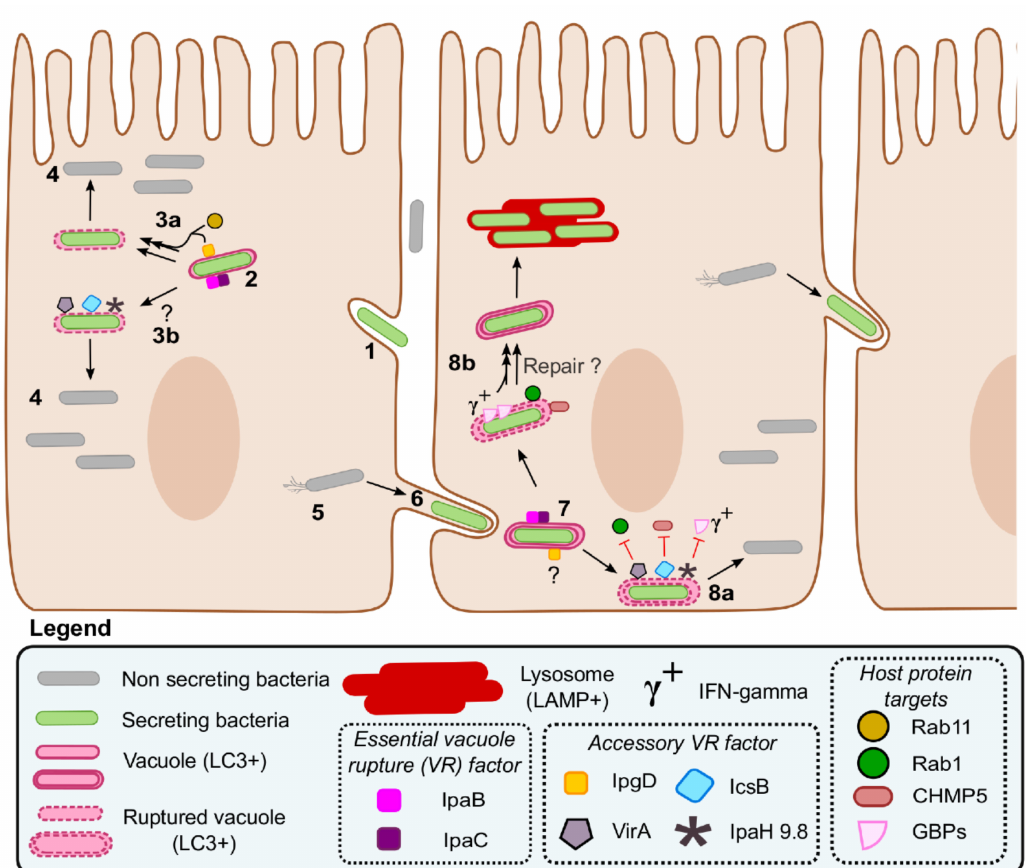
Figure 5. Shigella intracellular lifestyle and role of its virulence factors during vacuole escape. The invasion of a nonphagocytic host cell starts by the activation of T3SAs, which induce the remodeling of the plasma membrane through the action of their translocators and e ff ectors (1). The intracellular bacterium is captured in a single membrane entry vacuole; several T3SA substrates, including the translocators IpaB, IpaC, and IpgD, accumulate in the vicinity of the vacuole (2). IpaBC form pores that are essential to vacuole rupture; the IpgD-dependent recruitment of Rab11 might accelerate this process (3a); although the other accessory vacuole rupture factors IcsB, VirA, and IpaH9.8 are dispensable during entry in epithelial cells, they might be important in yet undiscovered conditions such as in immune cells or in specific cytokinic contexts (3b). Cytosolic bacteria proliferate (4) and move using actin comets (5). Upon contact with the plasma membrane, the T3SA is reactivated, allowing the formation of a protrusion (6) and a double membrane dissemination vacuole (7). IpaB and IpaC initiate the rupture of the double membrane dissemination vacuole; the role of IpgD at this stage is unknown. The accessory VR factors IcsB and VirA, and probably IpaH9.8 in the presence of interferon-gamma (IFN γ ), facilitate the escape of Shigella from the dissemination vacuole already partly ruptured by IpaBC (8a); this is probably realized through the inhibition of their respective targets CHMP5, Rab1, and GBPs. These WT bacteria can then resume cell-to-cell spread. By contrast, in the absence of these accessory VR factors, the repair of the partially ruptured vacuole is induced by Rab1 and CHMP5 (8b), a process that might also be facilitated by the action of the GBPs when IFN γ is present. These mutants (8b) are more often captured in lysosomes and partly deficient in cell-to-cell spread. The formation of the dissemination vacuole and its rupture depends on the T3SS, thus sharing some similarities with the entry. Nevertheless, due to the a ffi xation of the plasma membrane of both host cells, the dissemination vacuole has a double membrane. This might explain the critical role of additional e ff ectors in the escape from the dissemination vacuole, as described